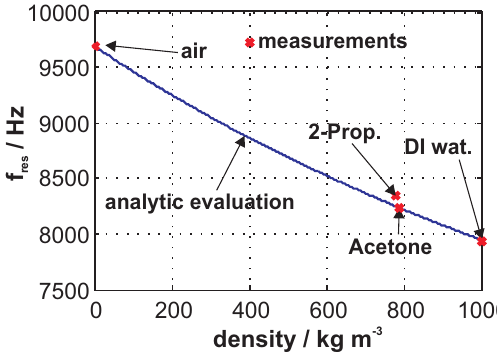
Figure 8. Measured resonance frequencies of di ff erent fluids and the respective predictions using Eqn. 10, where the Young modulus of the membrane has been fitted to meet the resonance frequency in air.